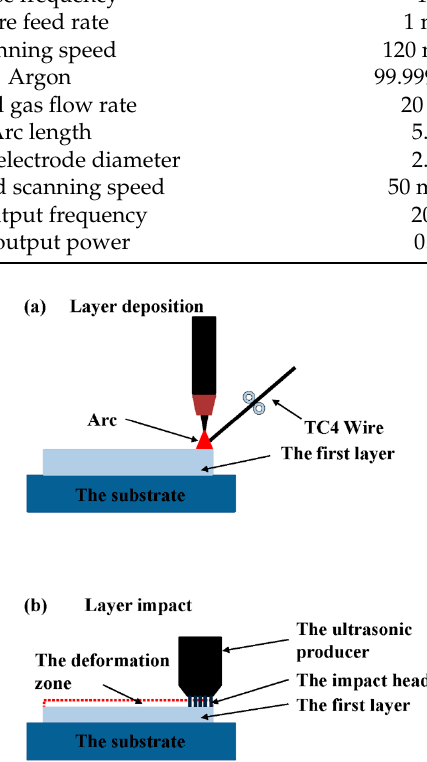
Figure 3. Schematic view of the hybrid manufacturing process of one layer. ( a ) the first step: Additive manufacturing process; ( b ) the second step: Ultrasonic impact treatment.